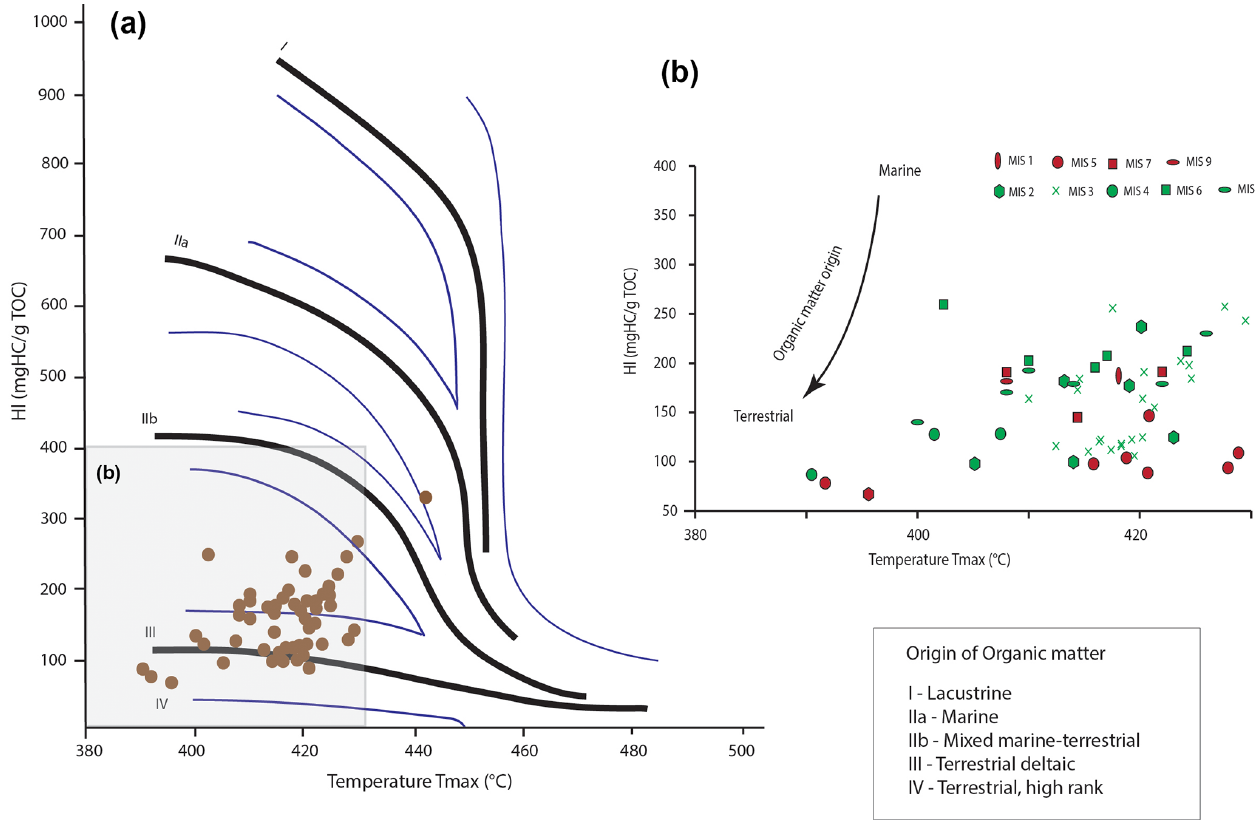
Figure 6. (a) Hydrogen index (HI; mgHCg − 1 TOC) vs. T max ( ◦ C) obtained by Rock-Eval6 pyrolysis. (b) Close-up. The organic matter origin becomes more terrestrial with decreasing HI